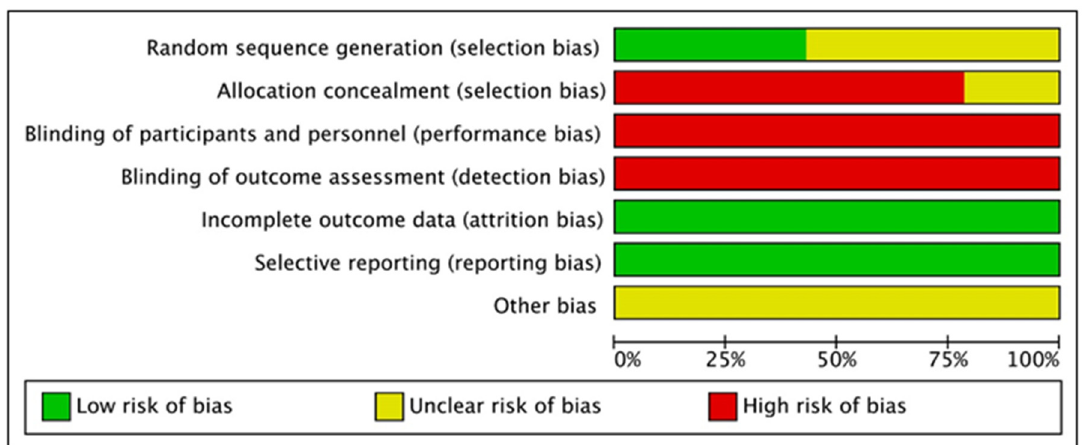
Figure 3. Risk of bias summary for all included studies.